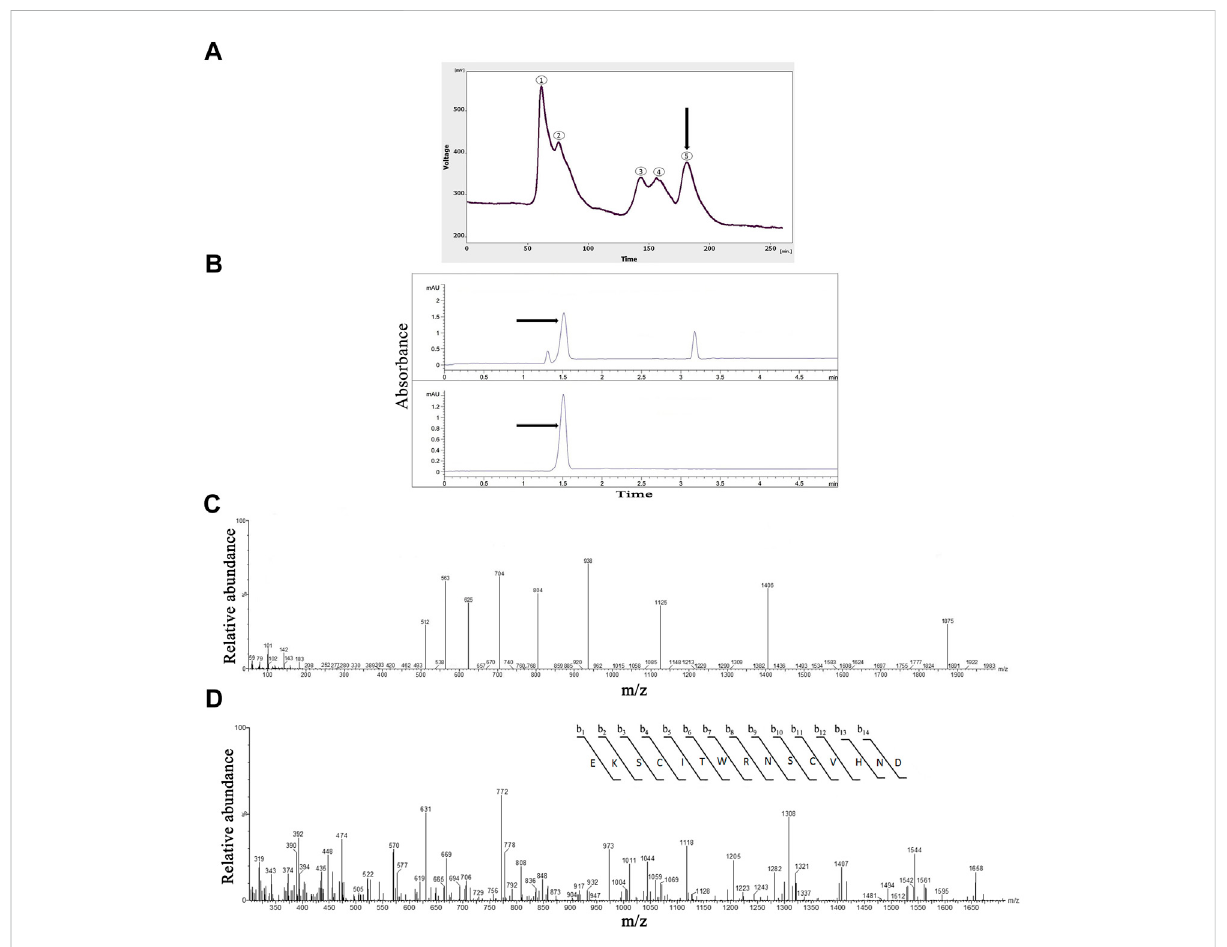
FIGURE 1 The Puri fi cation, and identi fi cation of OLG1e from the Lycosapraegrandis crudevenom. (A) Gel- fi ltration chromatography ofthe crude venom performed on a GE Healthcare HiLoad 16/600 Superdex ® 75 pg prep grade column in 1 M PBS (pH 7.4), fl ow rate 0.7 ml/min. The fi fth fraction is shown by black arrow. (B) Capillary electrophoresis of the sixth fraction was performed on a 50 μ m uncoated silica column 1 M PBS (pH 4.7) for 5 min.TheOLG1efractionisshownbyblackarrow. (C) HPLC-ESI-MSoftheOLG1efractionwasperformedonaofAtlantisT3-C18column.The spectrumresultsareshowninpart (C) . (D) N-terminalpartialsequencingoftheOLG1eprotein.ThesinglychargedionoftheN-terminalpeptide(m/z, 1,406) was subjected to the fragmentation in the ion trap mass analyzer. Fragment ions observed are indicated above and below the peptide